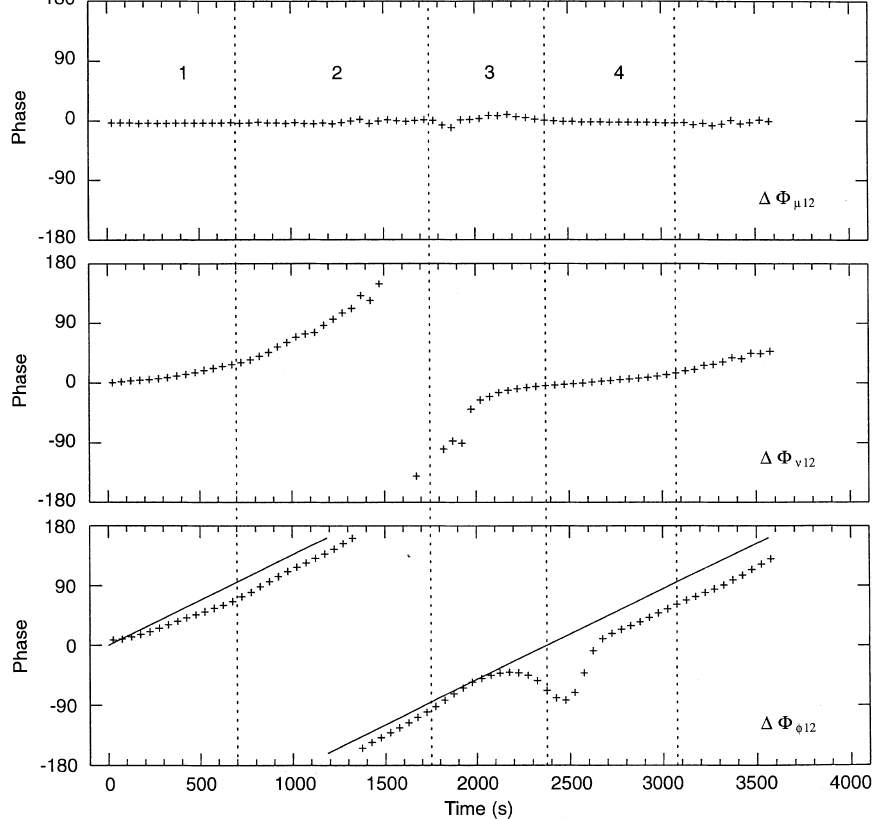
Fig. 6. The temporal development of the phase di(cid:128)erence between two magnetic field perturbations (sepa- rately for each component) across the FLR for a selected frequency band around 20 mHz that includes the resonant frequency in the sys- tem (high resolution grid). The solid line in the lower panel indicates a purely linear phase shift between the